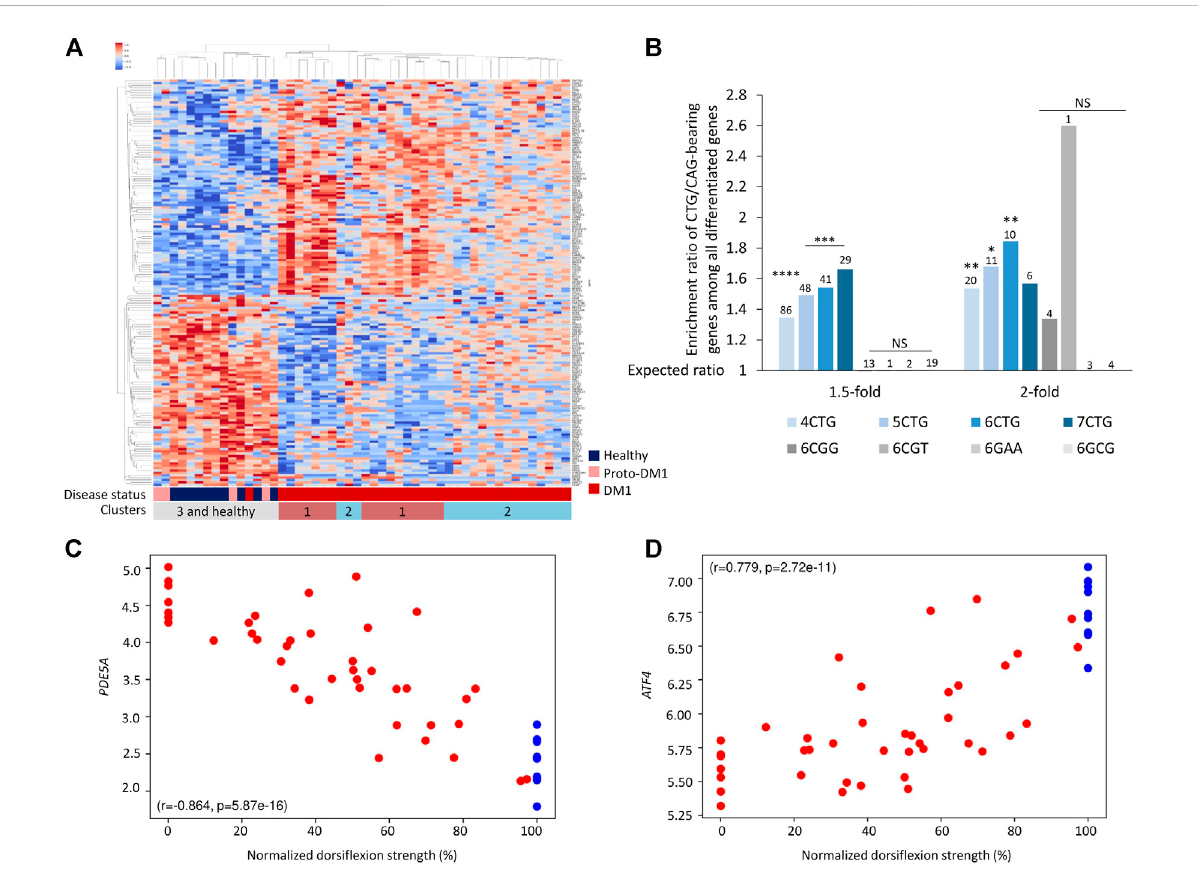
FIGURE 2 Genes bearing endogenous CTG/CAG -repeats are differentially expressed between DM1 patients and controls. (A) Heatmap of normalized expression levels of differentially expressed genes bearing endogenous 6CTG/CAG repeats across Tibialis samples from 40 DM1 patients and 10 healthy controls. (B) Bar plot presents ratio of genes bearing CTG/CAG repeats that are differentially expressed in DM1 samples divided by the expected number derived from the prevalence of those genes in the tissue. Different fold-change thresholds and lengths of consecutive CTG/ CAG repeats are presented. Additional combinations of pathogenic repeats (6CGG, 6CGT, 6GAA, and 6GCG) are depicted in gray. The number of genes differentially expressed for each group is indicated above the corresponding bar. Bars with at least two differentially expressed genes are presented. (C,D) Expression levels of top-ranking differentially expressed genes bearing 6CTG/CAG repeats relative to normalized dorsi fl exion strength of 40 DM1 patients and 10 healthy individuals. Pearson ’ s correlation coef fi cient ( r ) and p -value ( p ) are depicted. *0.05; **0.01;